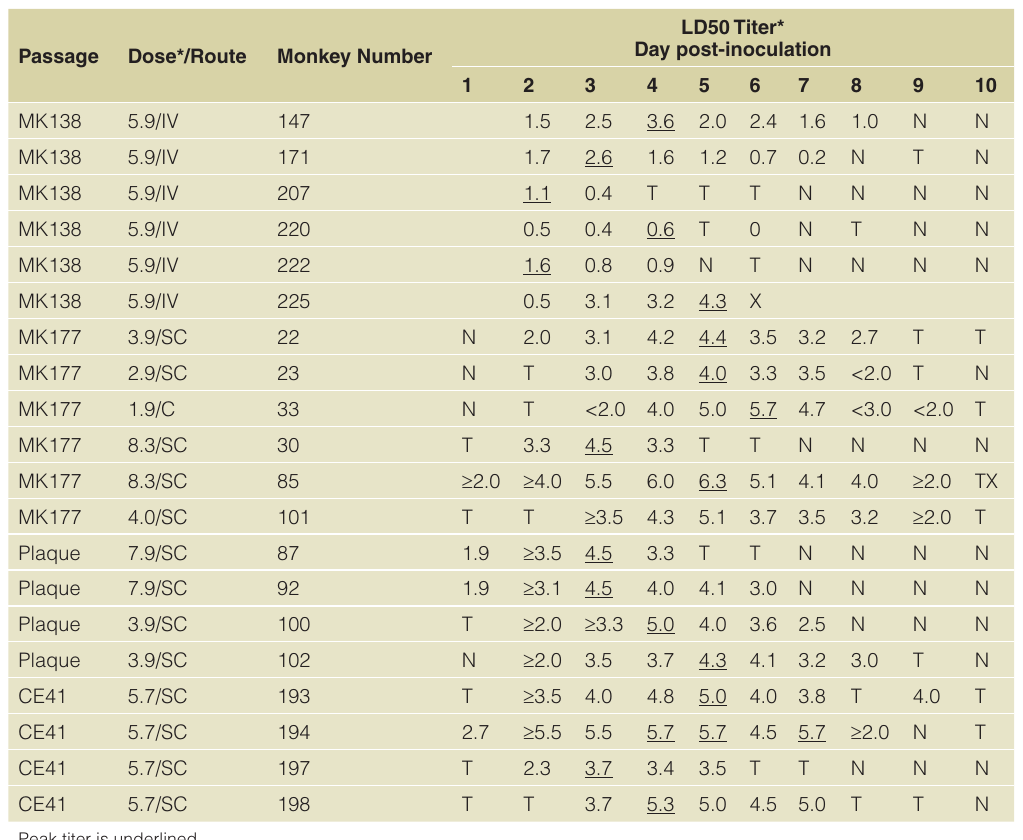
LD50 Titer* Day post-inoculation